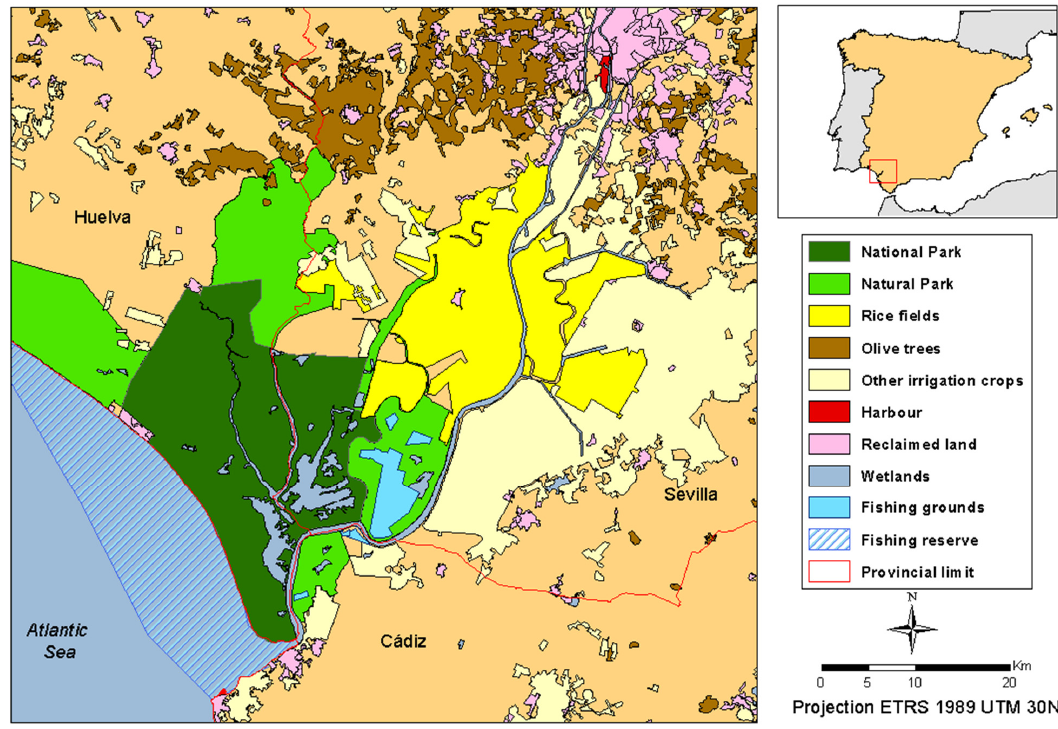
Figure 1. Main water uses in the lower Guadalquivir valley.